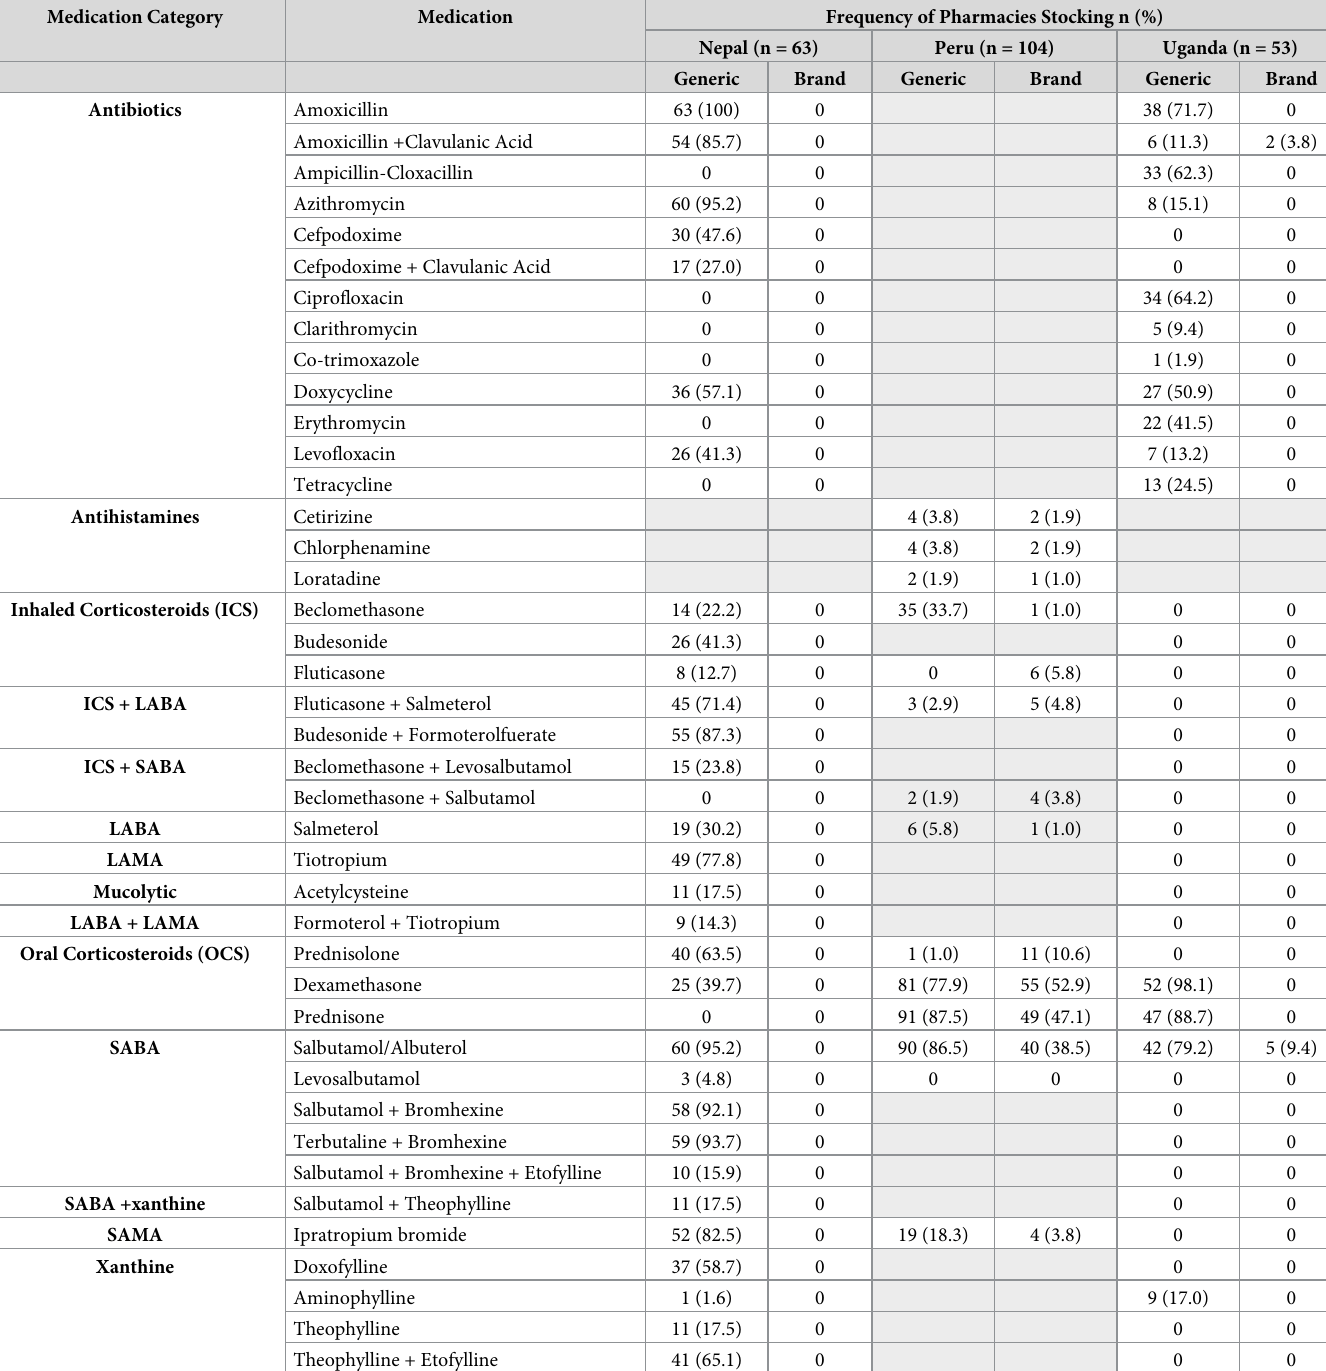
Table 1. Availability of respiratory medications in Bhakthapur Nepal, Lima Peru and Nakaseke Uganda by generic and brand name. Grey indicates no available data. Medication Category